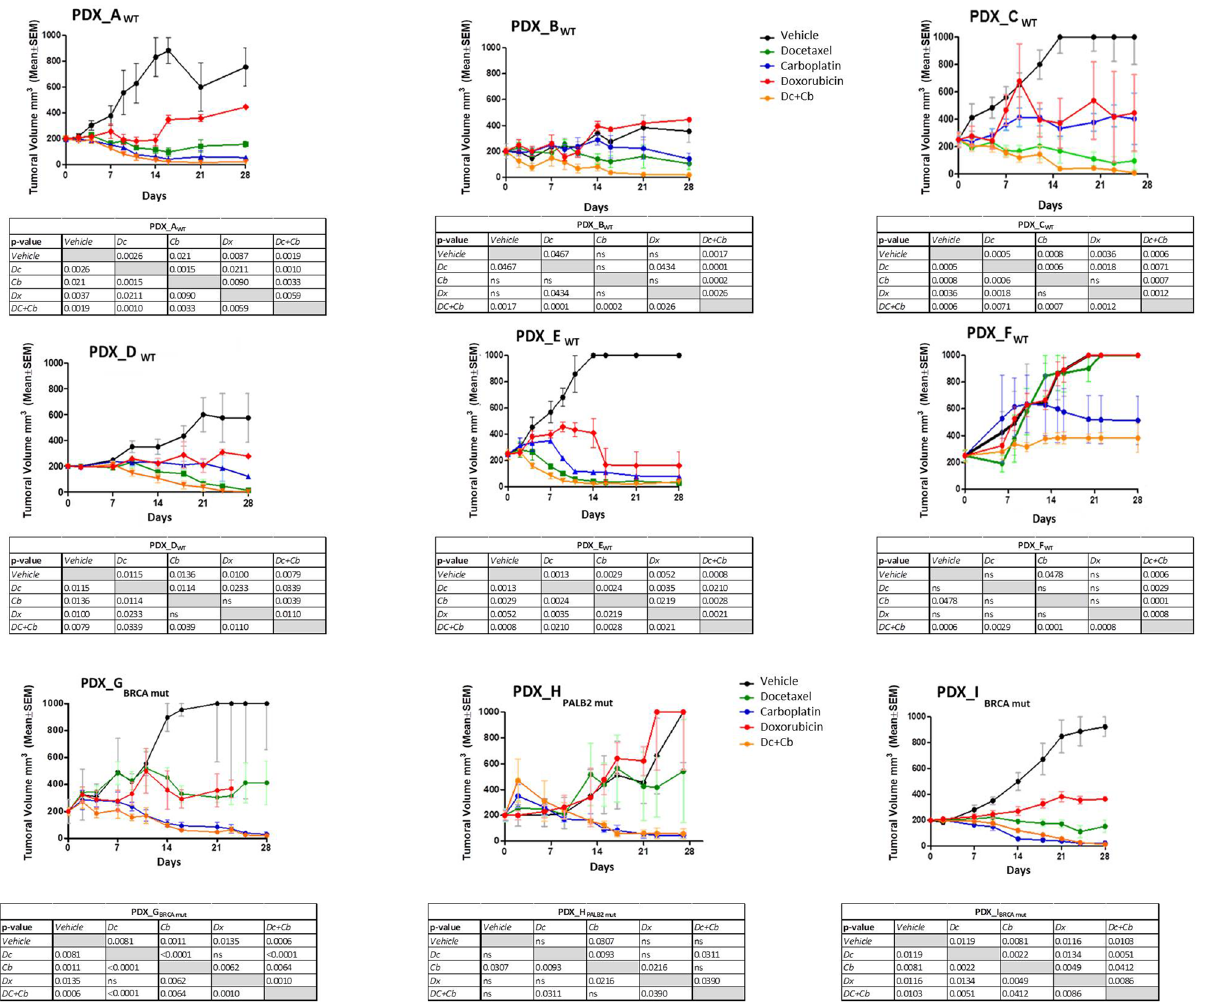
Figure 2. Tumor volume evolution. Volume reduction in the nine PDX models with ten mice per group WT, BRCA1/PALB2 WT; MUT, BRCA1/PALB2 mutation; PDX, patient-derived tumor xenograft; NAC, neoadjuvant chemotherapy; ypTNM iatrogenic pathological TNM after NAC treatment; RCB, residual cancer burden; Dc + Cb, docetaxel + carboplatin; TV, tumor volume; TGI, tumor growth inhibition; D0, Day 0; D28, Day 28. Tumor volume was measured using a caliper three times a week and calculated as [tumor length × tumor width 2